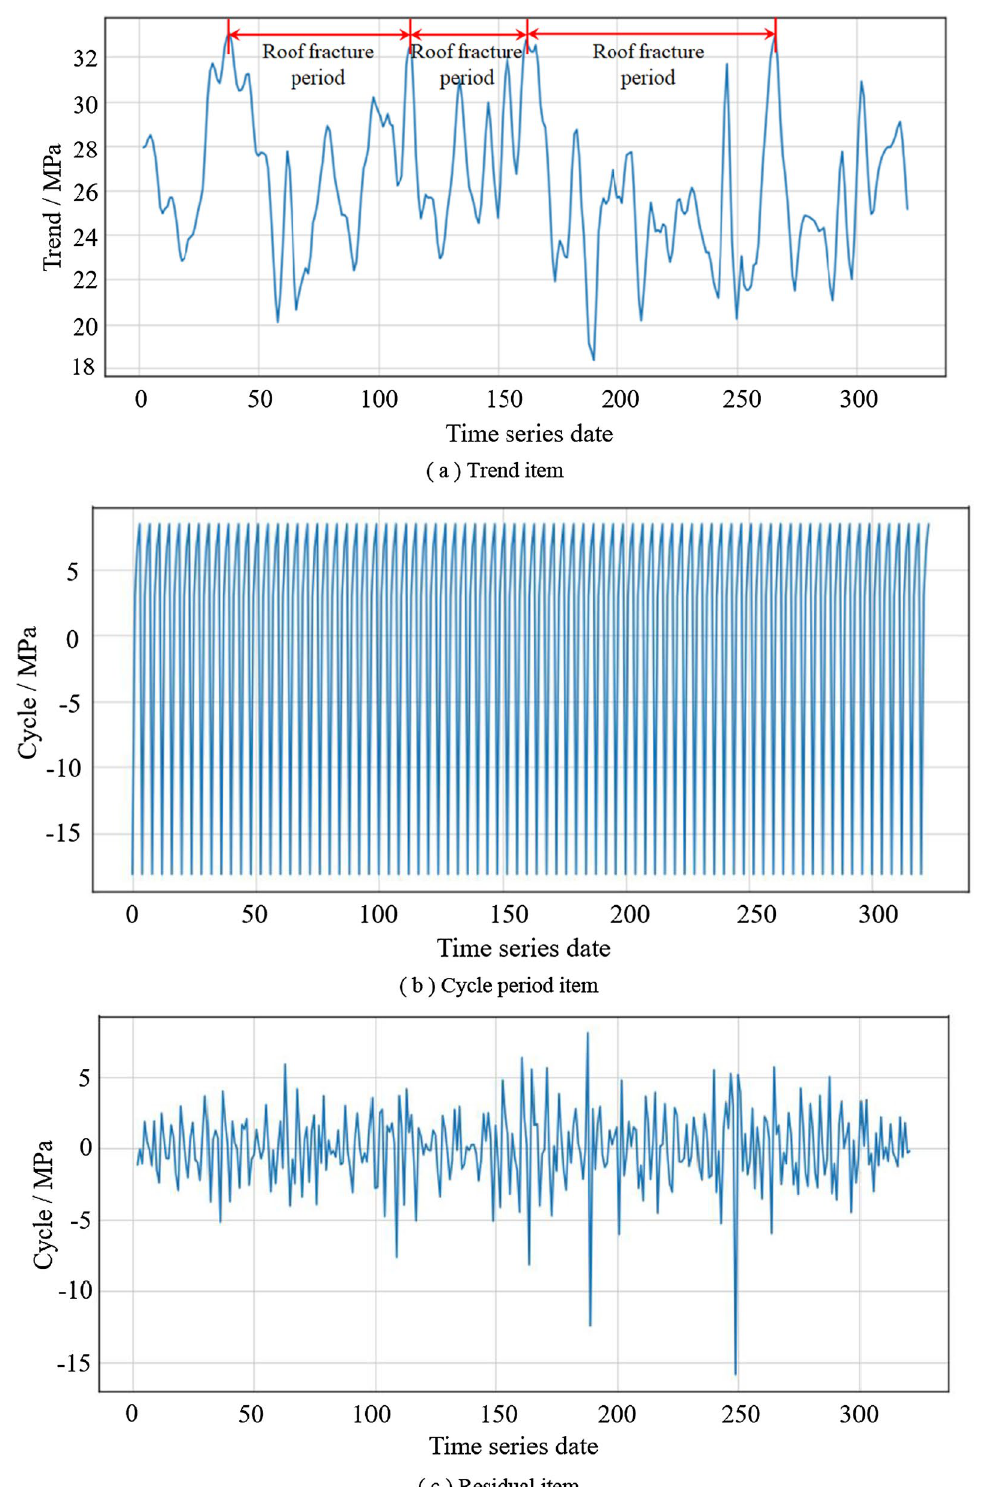
Fig. 6 Feature decomposition of the preprocessed monitoring data for the support